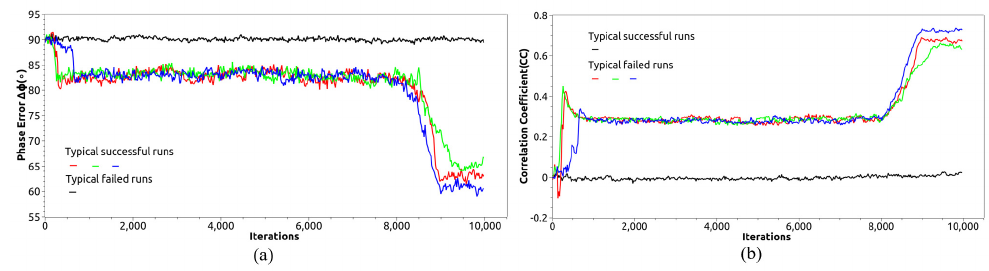
Figure 9. Ab initio phasing of 6c4z. Evolution of error metrics starting from random phase: ( a ) ∆ ϕ , ( b ) CC . When a solution is reached, ∆ ϕ indicates a sudden drop, and CC shows a sudden rise. After 9000th iteration, solvent flattening is applied.